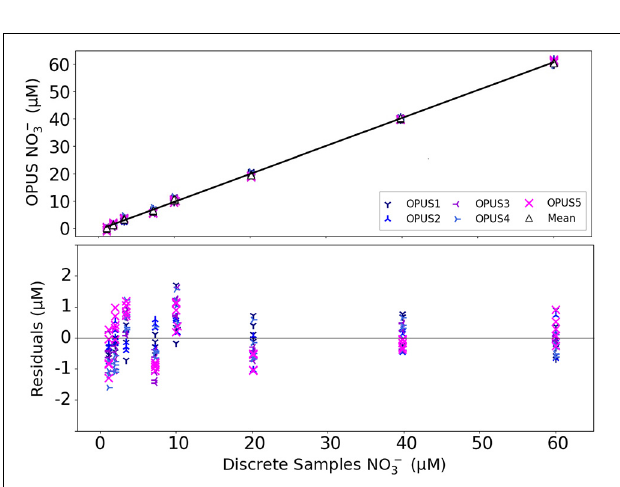
FIGURE 10 | Linear regression fit (solid line) between mean NO 3 − concentrations from the OPUS sensors vs. laboratory analysis of discrete water samples ( y = 1.021 x –0.641, r 2 = 0.99). The residuals of the regression for each sensor were within ± 2 µ M NO 3 − .